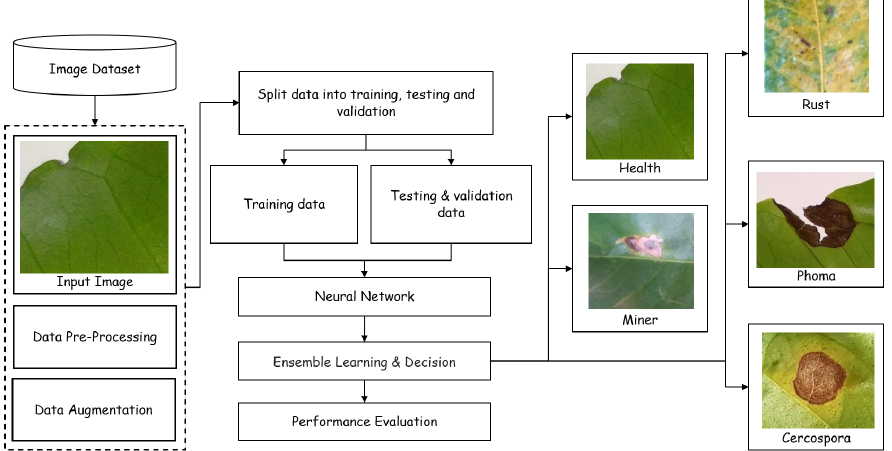
Figure 1. Block diagram of the proposed